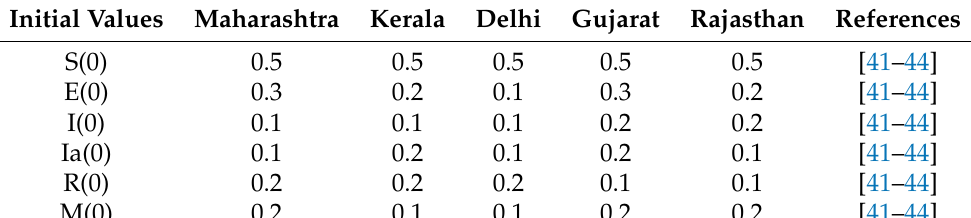
Table 8. Initial Values of parameters in the states of Maharashtra,Kerala, Delhi, Gujarat and Rajasthan. Initial Values